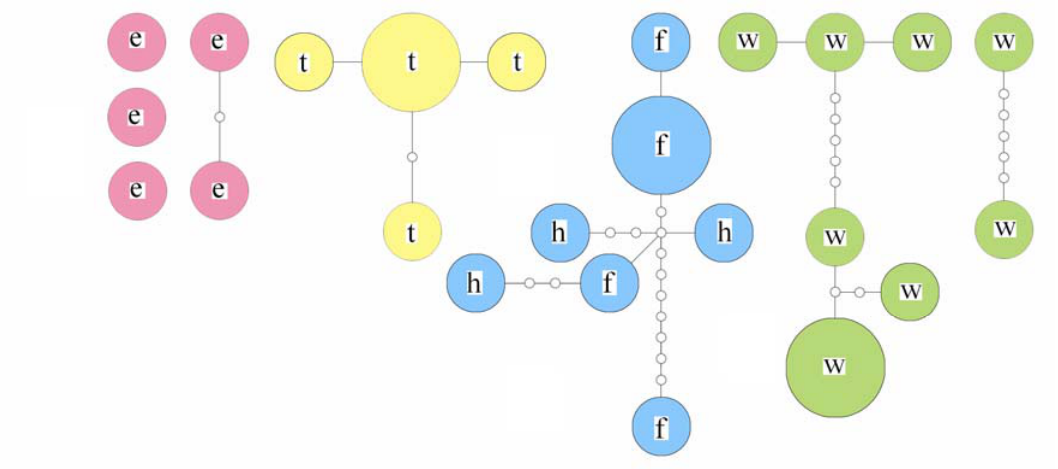
F IG . 3 . Haplotype networks of Allactaga spp. (27 individuals), based on 616 bp of the cytochrome oxidase subunit I gene ( Cox1 ). Networks were not joined if haplotypes were separated by more than 9 mutations. Each circle represents one haplotype. (pink circles (e): A. elater , yellow circles (t): A. toussi , blue circles (h, f): A. hotsoni and A. firouzi , green circles (w): A. williamsi